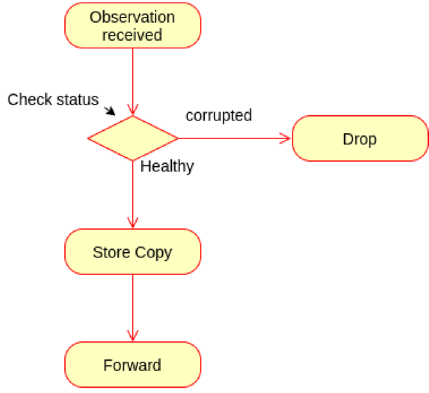
Figure 17. Behaviour of observation